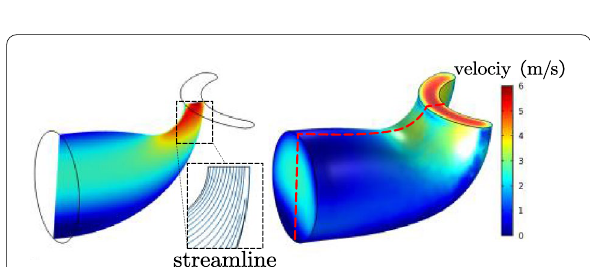
Figure 11 Velocity distribution of the optimized suction